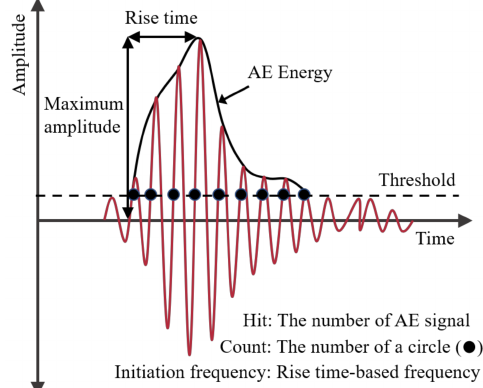
Figure 6. Example of six acoustic emission (AE) parameters in an AE signal. In this study, these AE parameters were transformed as cumulative values and used as inputs for predicting the degree of rock